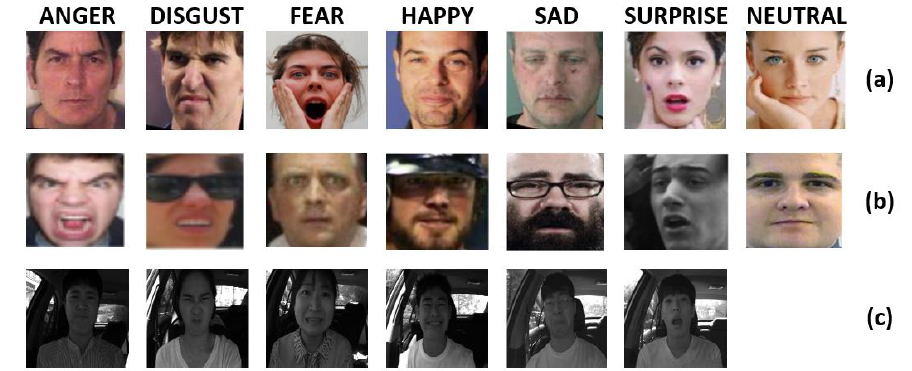
Figure 7. Sample images from ( a ) RAF-DB, ( b ) AffectNet and ( c ) KMU-FED datasets.